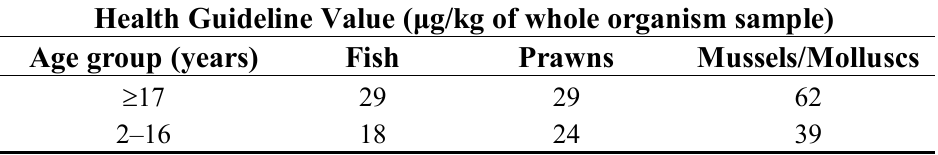
Table 2. Acceptable daily limit for cylindrospermopsin with age and bodyweight. Age group (years) Average bodyweight (kg) Acceptable daily limit (μg/day) ≥ 17 74 11 2–16 38 5.7 Step 3: Obtain high-level consumption data for consumers aged 17 years and above and 2–16 years old—see Table 1. Table 3 . Acceptable limit (μg/day) ÷ consumption (kg/day) (that is Step 2 ÷ Step 3). Table 3. Health guideline values for cylindrospermopsin toxin in